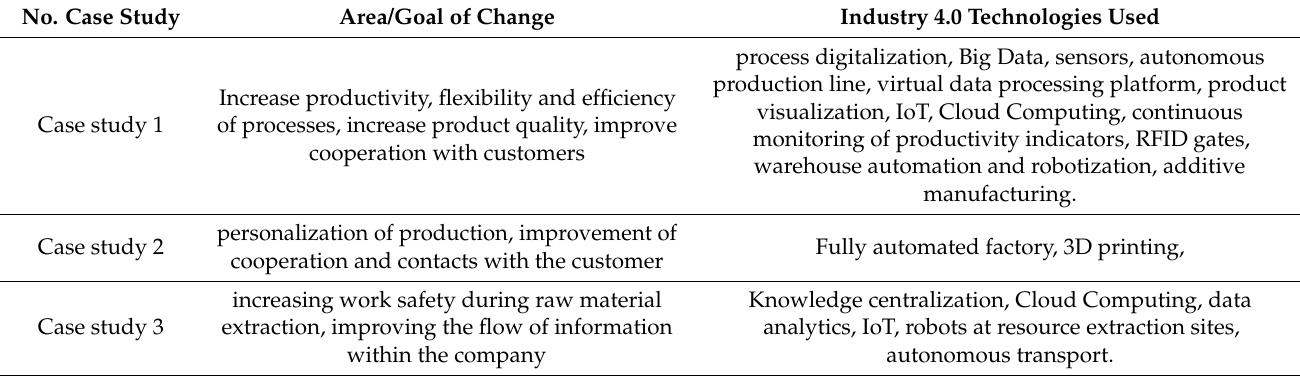
Table 10. Summarizes the areas and technology that was implemented through the transformation of the case studies